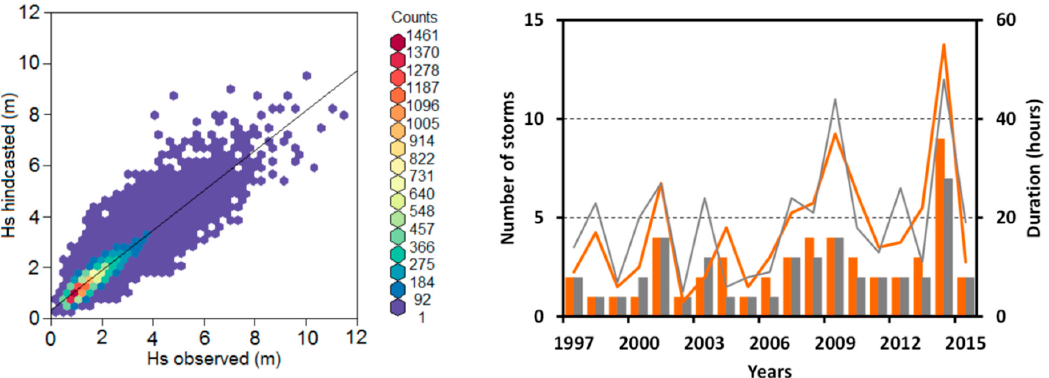
Figure 2. Scatterplot of observed versus modelled significant wave height ( left ) and comparison between derived storm parameters on the observed and hindcast output ( right ). Bars are the number of storms, lines are the duration of storms, orange are observed data, and gray are modelled data.